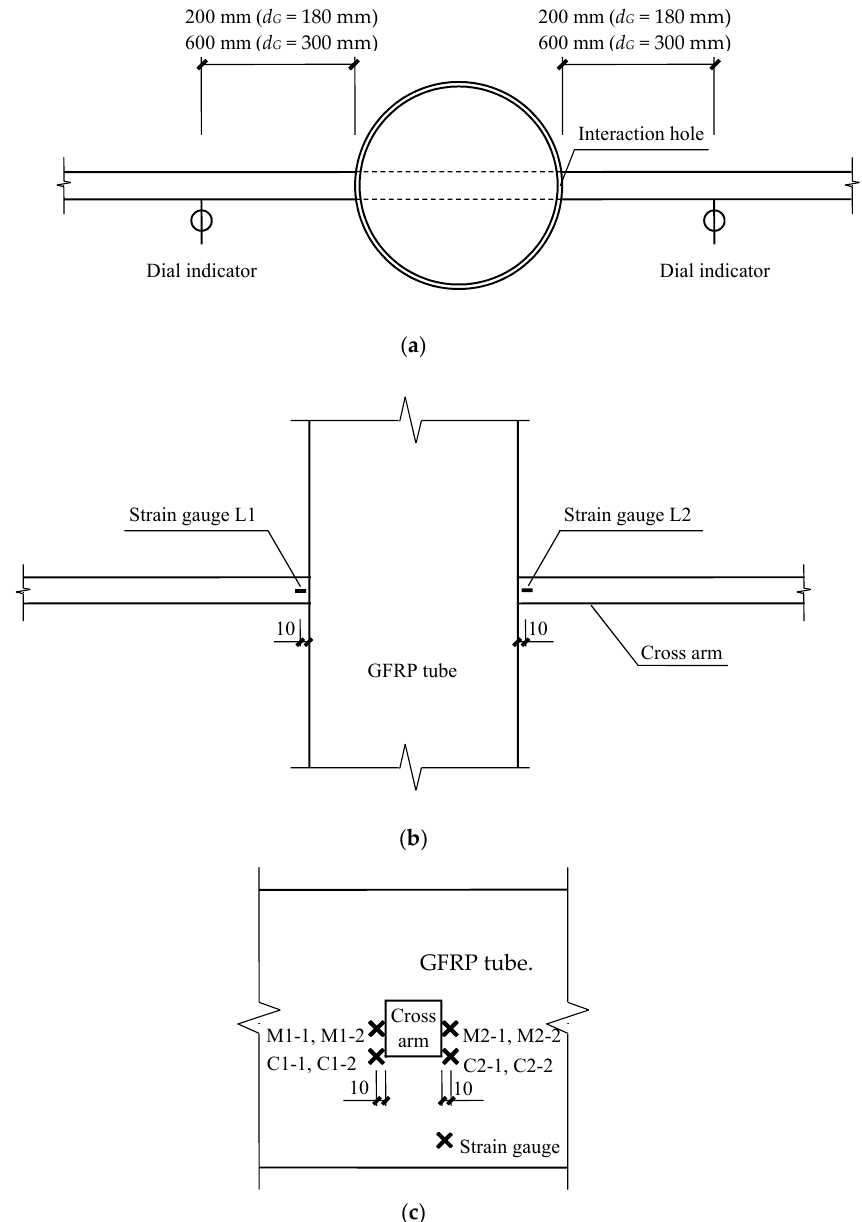
Figure 4. Data acquisition instruments: ( a ) Dial indicators on the cross arm; ( b ) strain gauges on the cross arm; ( c ) strain gauges on the GFRP tube.